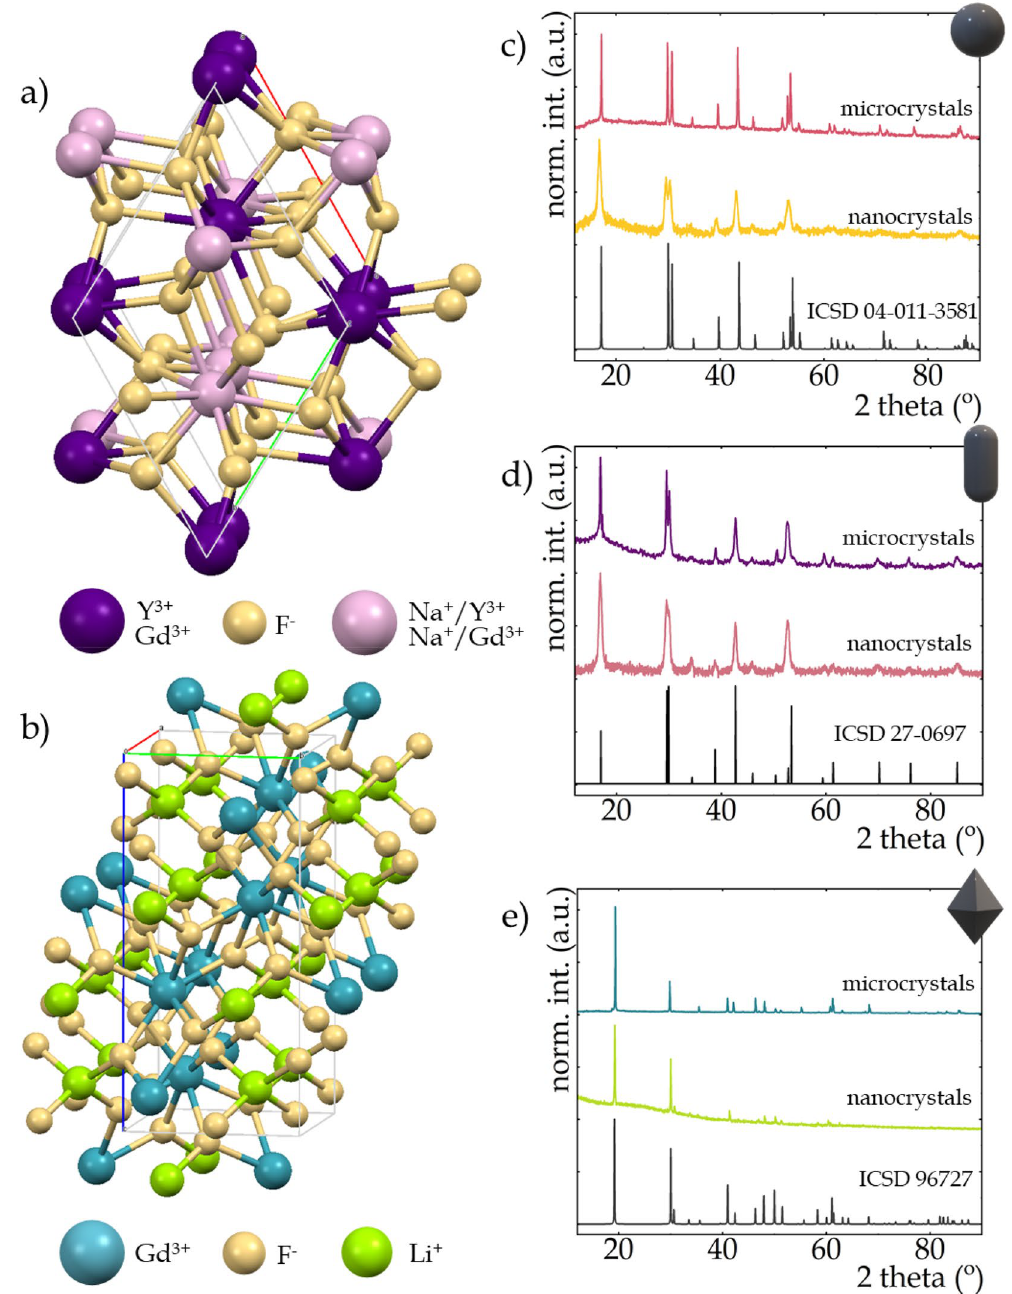
Figure 1. Visualization of Na + and Y 3+ or Gd 3+ sites in the hexagonal NaYF 4 or NaGdF 4 structures (prepared using Mercury 4.2.0 software) ( a ) and of Li + and Gd 3+ sites in the tetragonal LiGdF 4 structure ( b ); the Bragg reflections of β -NaYF 4 ( c ), β -NaGdF 4 ( d ) and LiGdF 4 ( e ) nanocrystals and